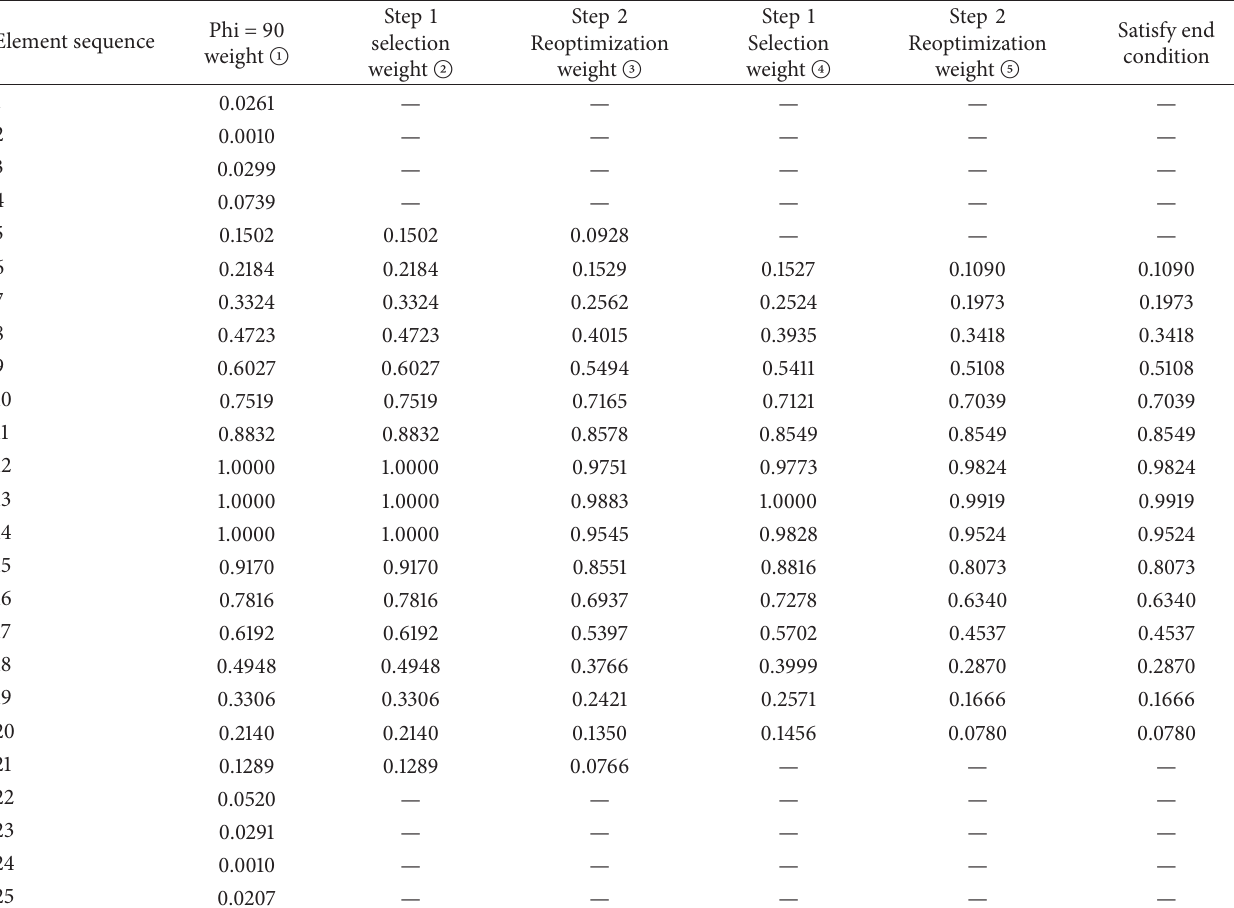
Table 4: Active elements selection